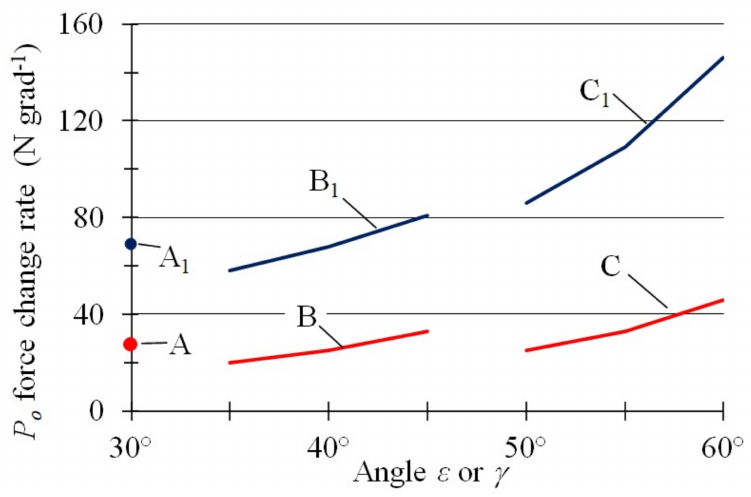
Figure 9. Dynamics of change ∂ P o · ( ∂γ ) − 1 ( — ) and ∂ P o · ( ∂(cid:101) ) − 1 ( — ) depending on the angles epsilon and γ : γ = 60 ◦ (point A); epsilon = 60 ◦ (point A 1 ); γ = 45 ◦ (curve B); (cid:101) = 45 ◦ (curve B 1 ); γ = 30 ◦ (curve C); and epsilon = 30 ◦ (curve C 1 ).